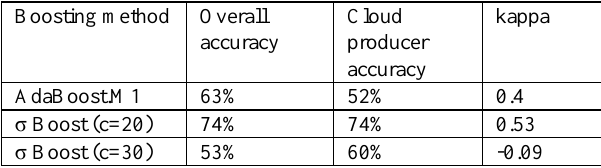
Table 2. overall accuracy, cloud producer accuracy and kappa coefficient of AdaBoost.M1 and σ Boost with c=30 and c=20